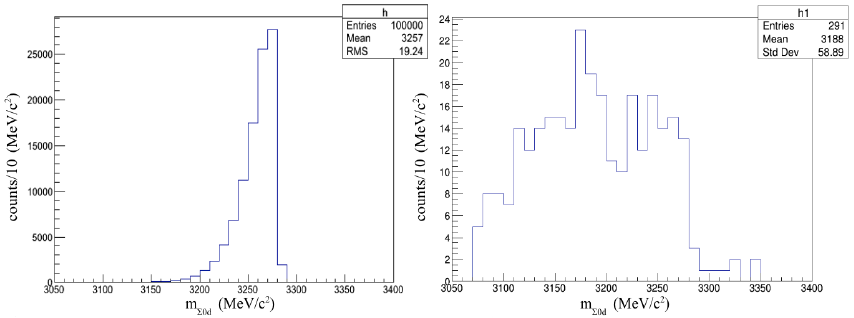
Figure 2. The panel on the left shows the calculated Σ 0 d invariant mass spectrum for the process in Eq. (1). This is compared with the measured invariant mass (right), of the Σ 0 d events reconstructed by using partial statistics from the 2012 data taking